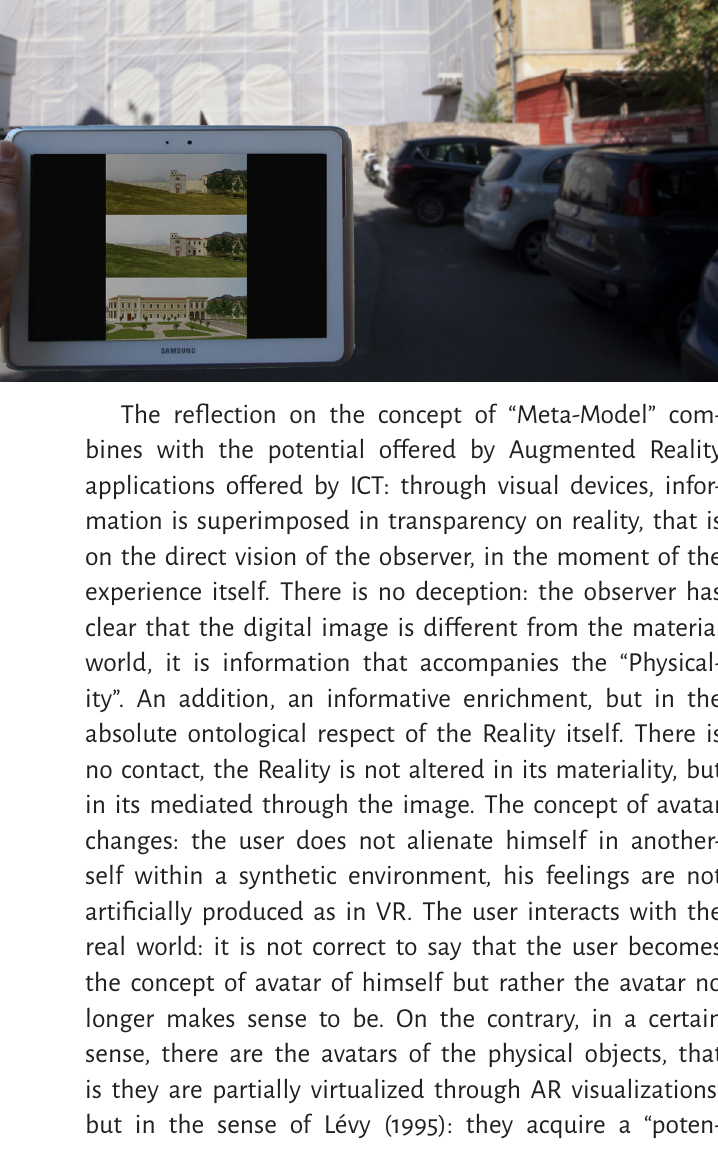
85 www.img-network.it